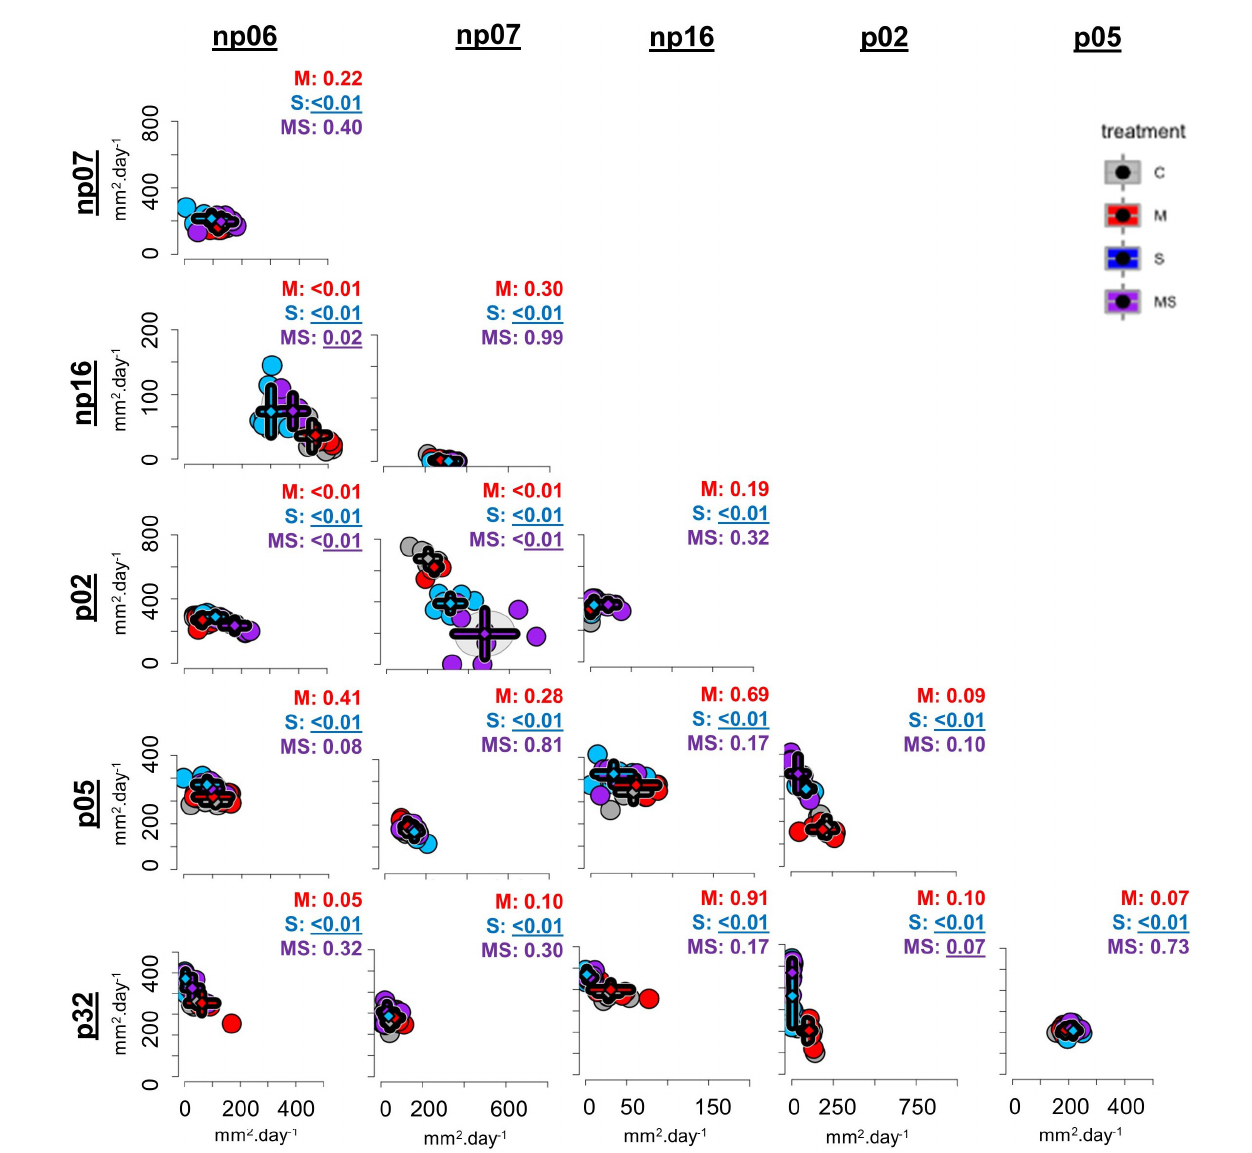
FIGURE1 The effects of none (control, C), mild (M), strong (S), and both (MS) heat stress events on fungal isolate growth rates for fungal isolates cultivated in pairs [ p -values from permutational multivariate analysis of variance (perMANOVA)]. Each dot represents one petri dish (one replicate for each treatment), while the rhombuses indicate the averages and the error bars the standard deviations for each treatment. The axes were scaled to optimize the comparison across pairs (for comparison of individual pairs refer to Supplementary Figure 2